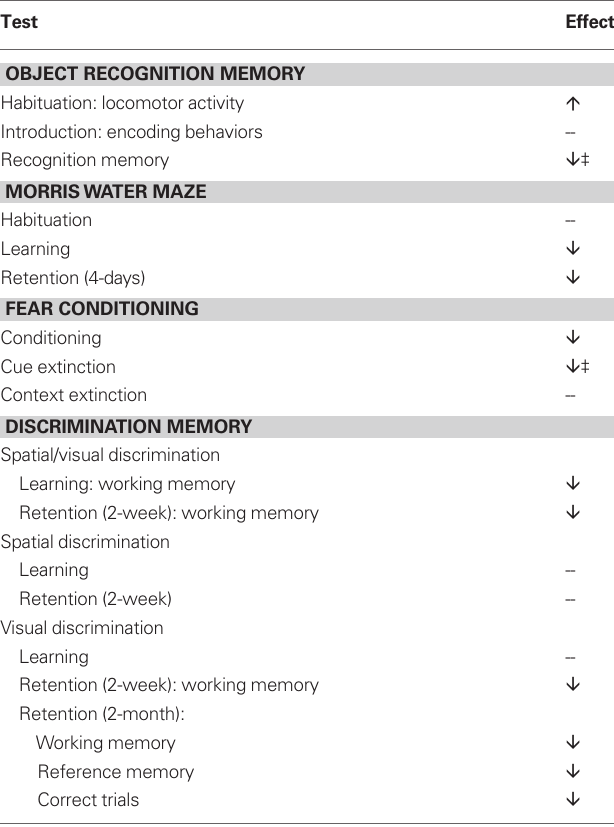
Table 1 | Summary of the cognitive deficits observed following exposure to repeated variable prenatal stress during the third week of rat